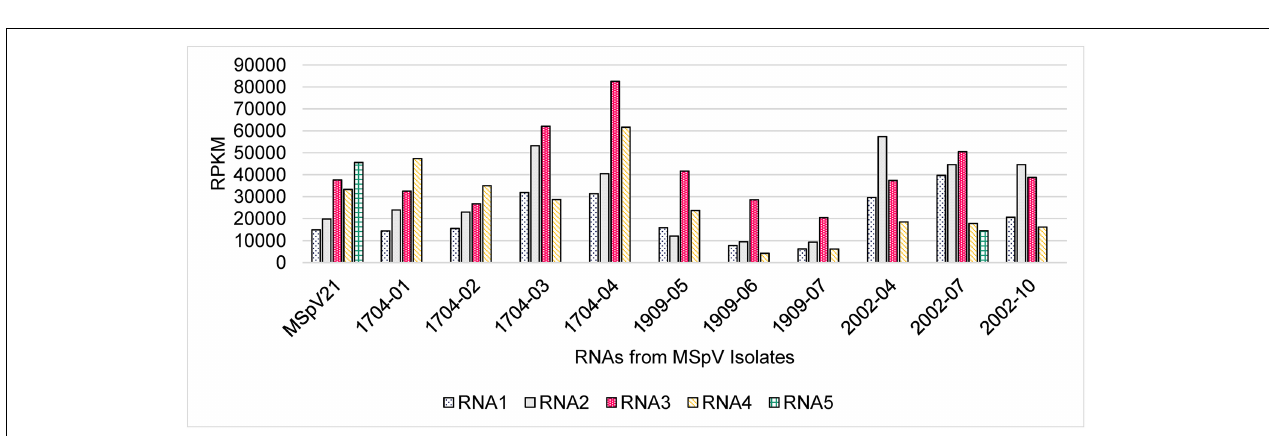
FIGURE 2 | The reads per kilobase per million reads (RPKM) measurements for the maize stripe virus RNA segments as detected by high-throughput sequencing. MSpV, maize stripe virus.